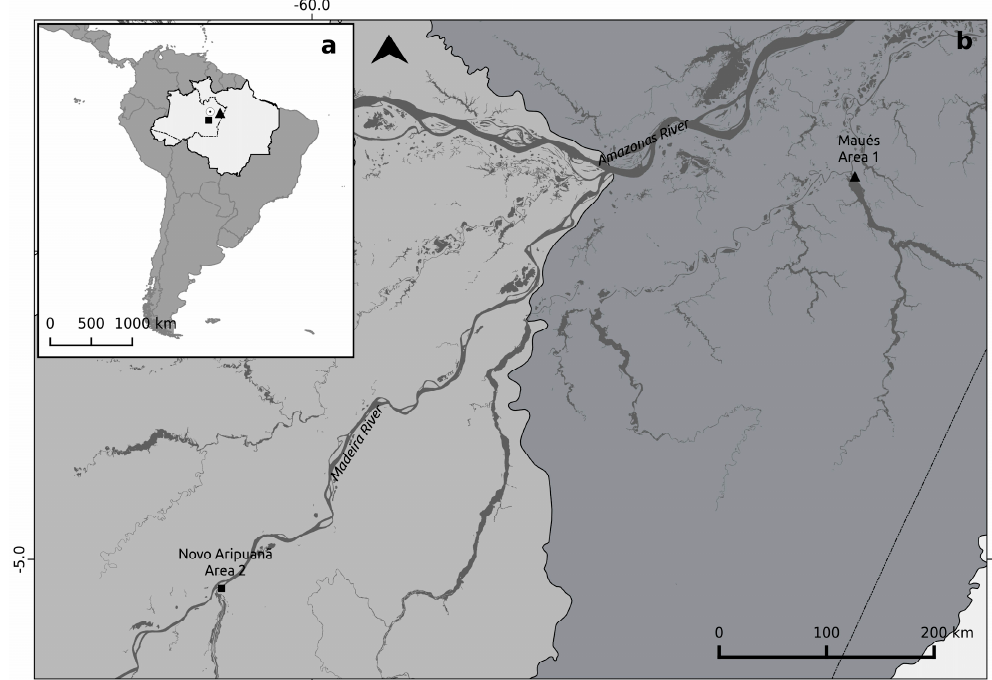
Figure 1. Map of study areas showing ( a ) Brazilian Legal Amazon and Amazon River sub-basins; and ( b ) Maués, directly linked to main Amazon River channel and Novo Aripuanã just inside Madeira River basin.